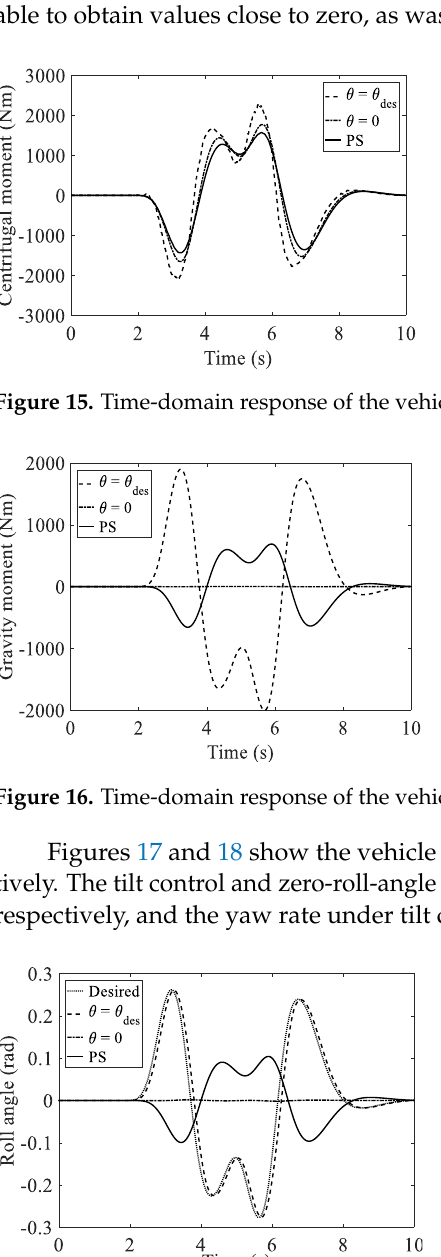
Figure 15. Time-domain response of the vehicle centrifugal moment.